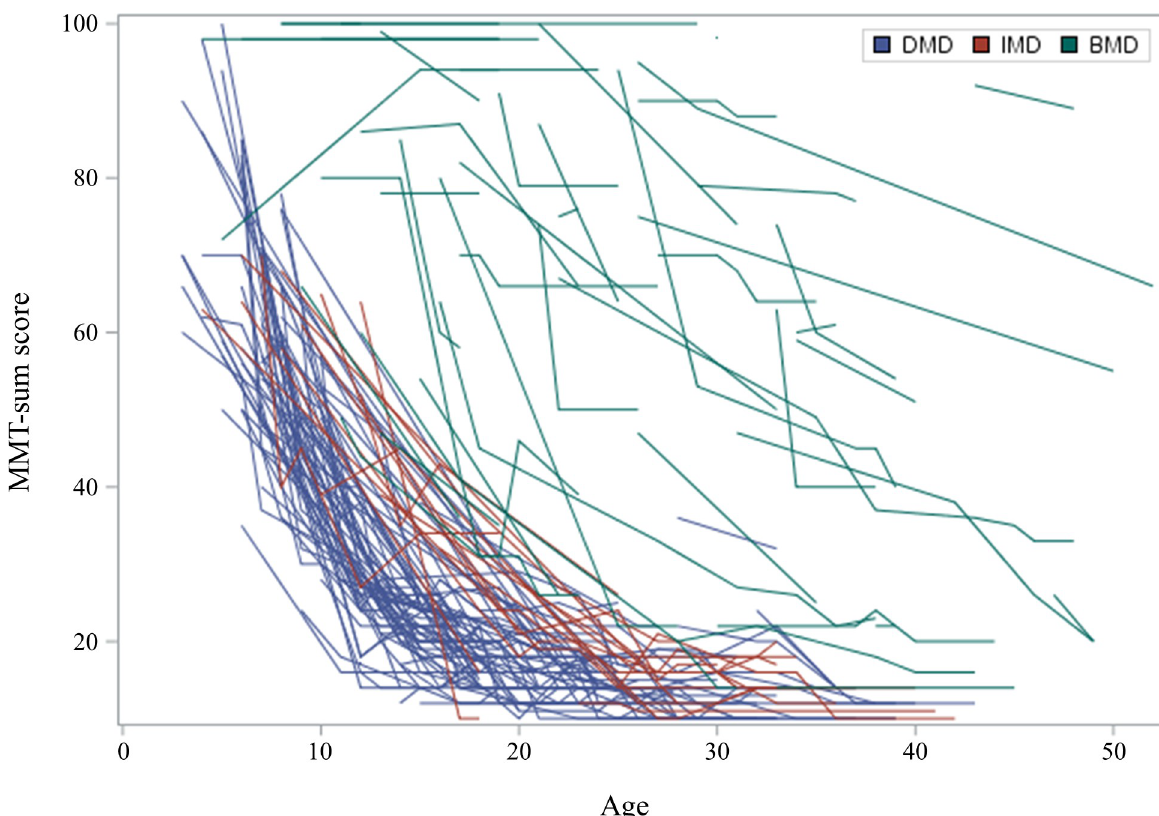
Fig 1. Changes in manual muscle test sum scores with age: A spaghetti plot. Individual changes in patients with Duchenne muscular dystrophy (DMD), intermediate phenotype muscular dystrophy (IMD), and Becker muscular dystrophy (BMD). Blue, red, and green colors indicate patients with DMD, IMD, and BMD, respectively. � MMT, manual muscle test: the MMT for strength was converted to an 11-point scale (0, 1, 2, 3-, 3, 3+, 4-, 4, 4+, 5-, and 5). The observed MMT scores ranged from 0 to 10 for each movement assessed. The total MMT score represents the sum of 10 strength values, including those for shoulder abduction, elbow extension, elbow flexion, wrist extension, wrist flexion, hip flexion, knee extension, knee flexion, ankle dorsiflexion, and ankle plantarflexion.